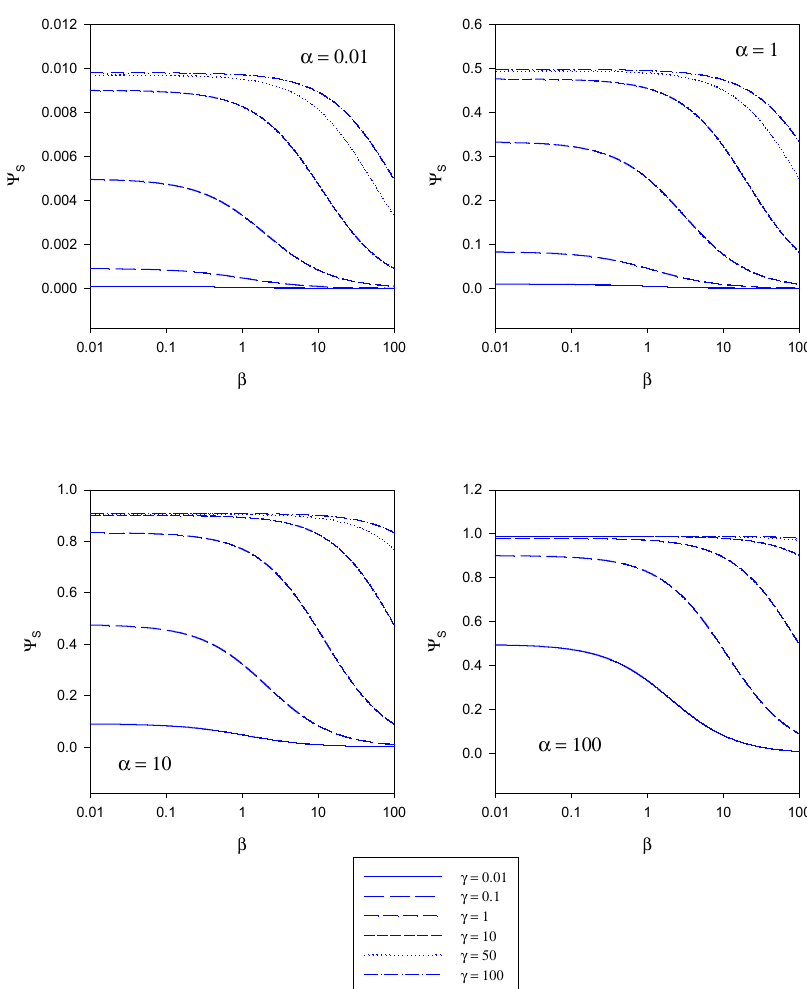
Figure 5. Variation of the normalized substrate flux with the mediator saturation parameter β computed from eqn. 20. The plots are computed for different values of the kinetic competiton parmeter γ which compares the mediator/enzyme reaction flux to the substrate/enzyme reaction flux. Each set of curves correspond to a fixed value of the substrate saturation parameter α